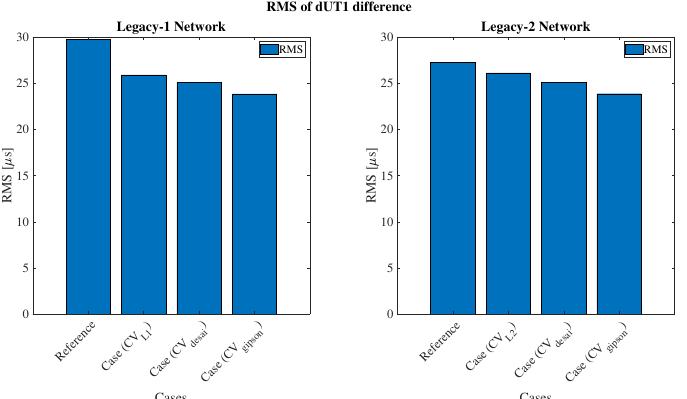
Figure 11. Root mean square of the differences between dUT1 from 24 h and IVS-Intensive sessions (with and without the addition of correction value); CV L 1 , CV L 2 , CV desai , and CV gipson are correction values computed with hourly dUT1 from L1 network, L2 network, Desai HFEOP, and Gipson HFEOP,